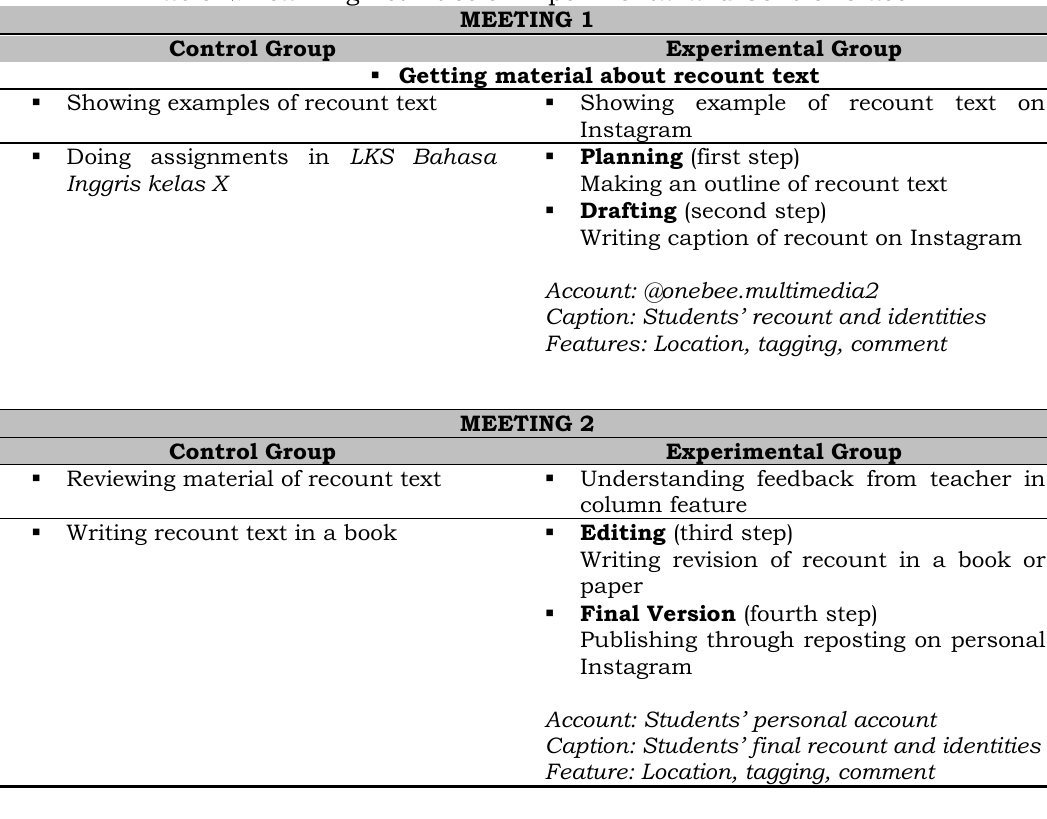
Table 2. Learning Activities of Experimental and Control